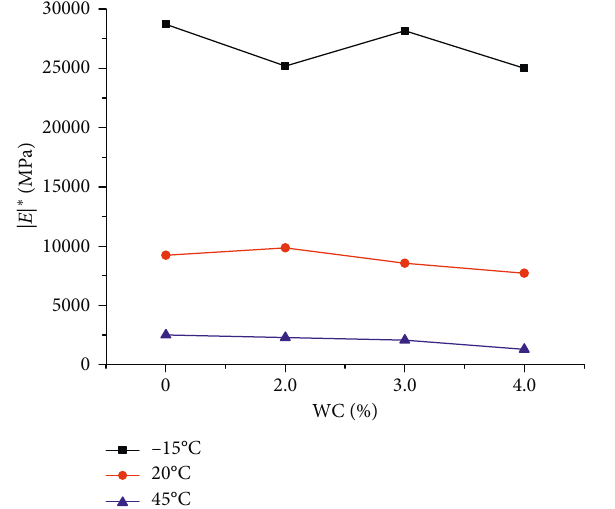
Figure 19: SBS#AC-20-type dynamic modulus varying with water consumption and temperature.